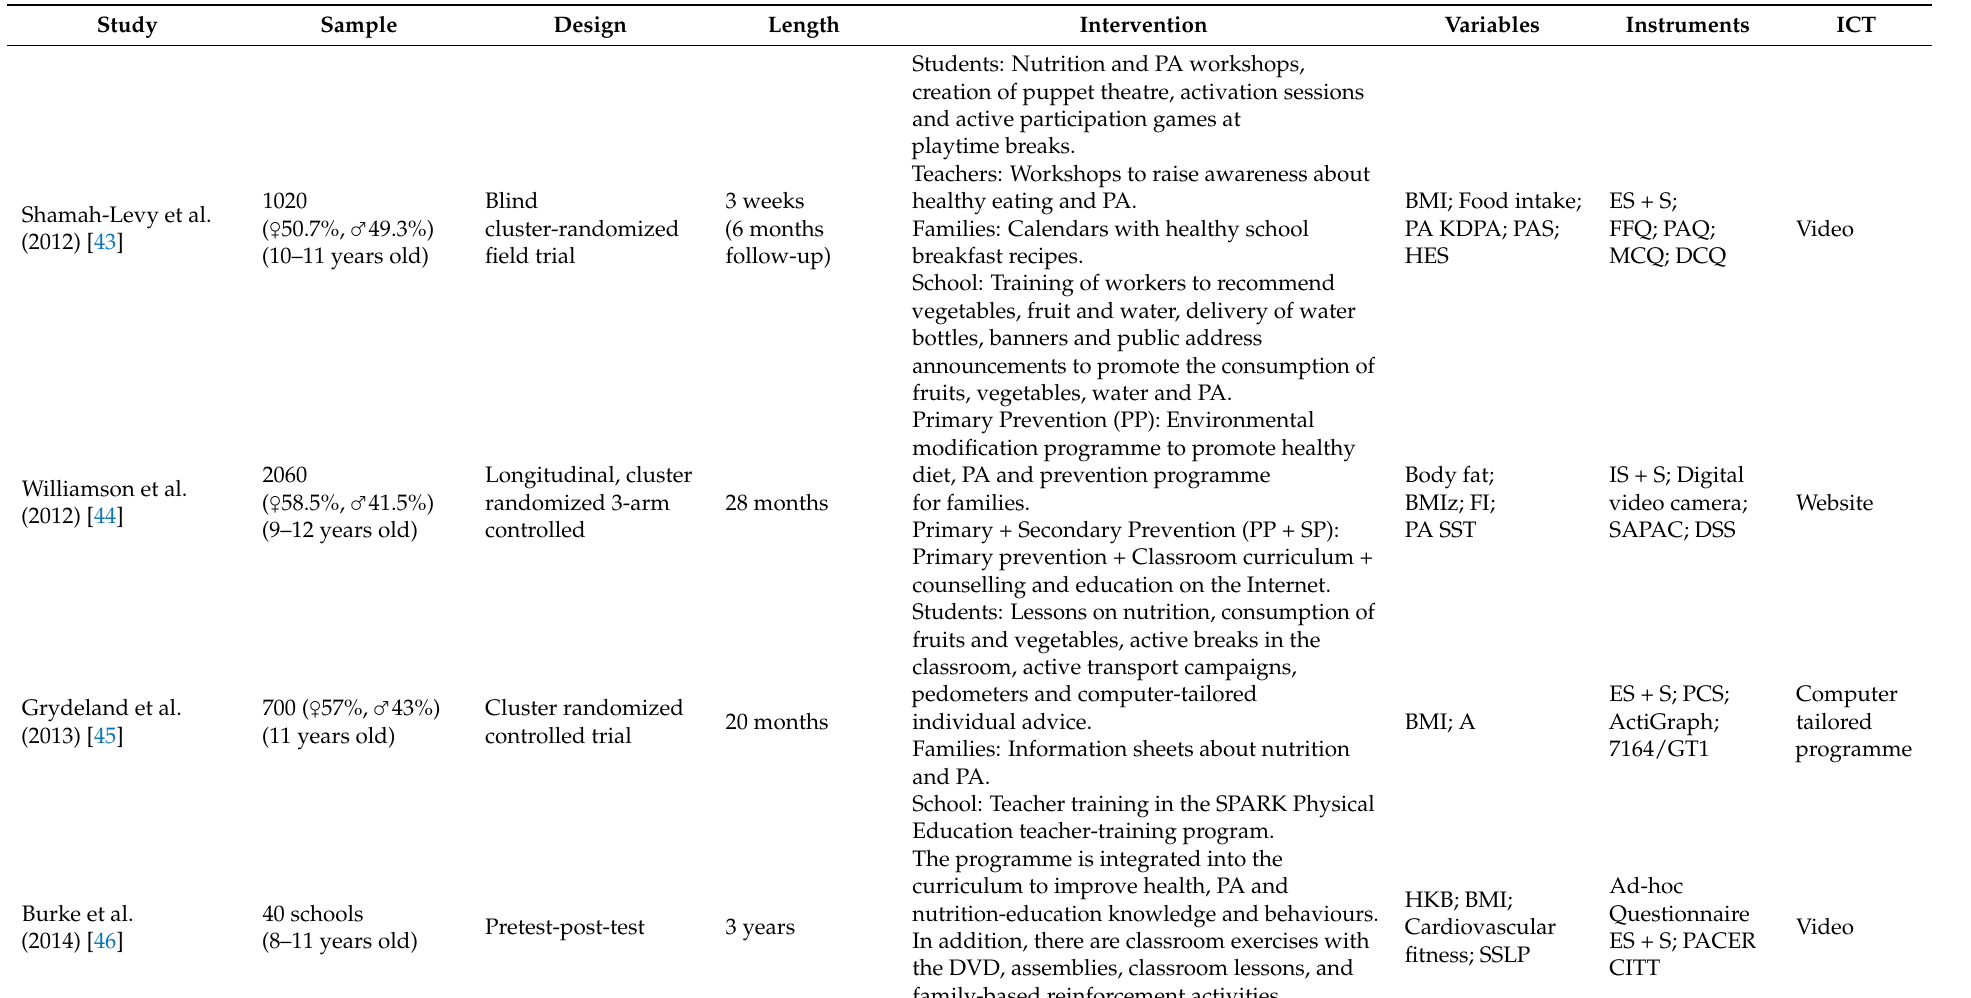
Table 1. Analysis of intervention